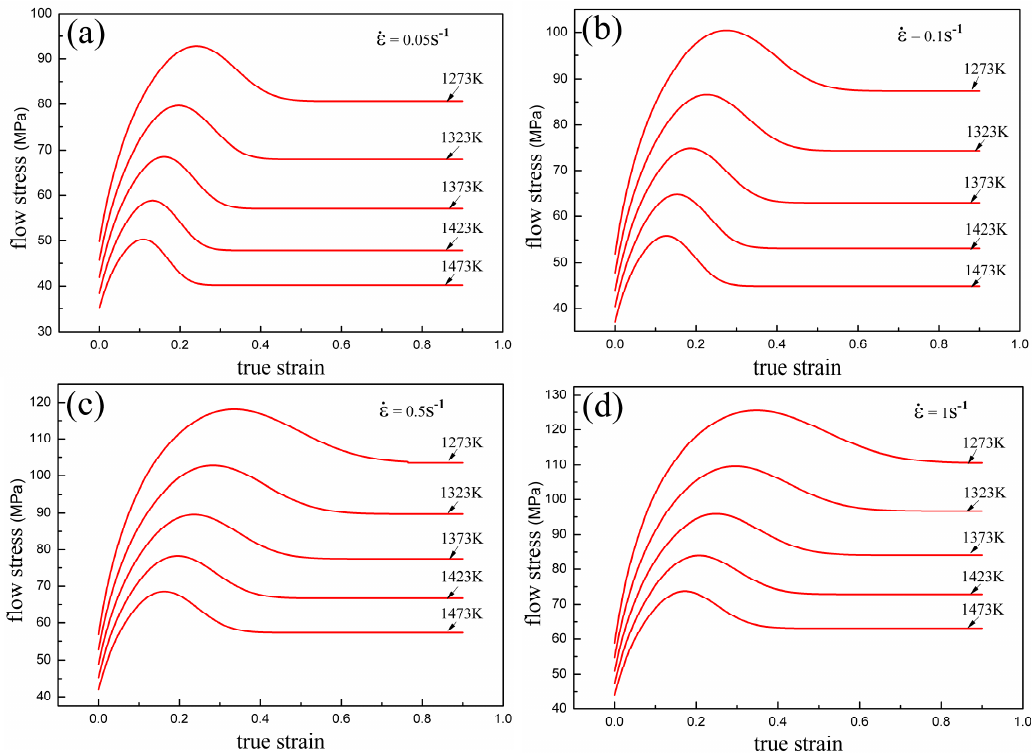
Figure 16. Calculated flow stress curves using the Avrami kinetic-based constitutive model of Armco-type pure iron: ( a )